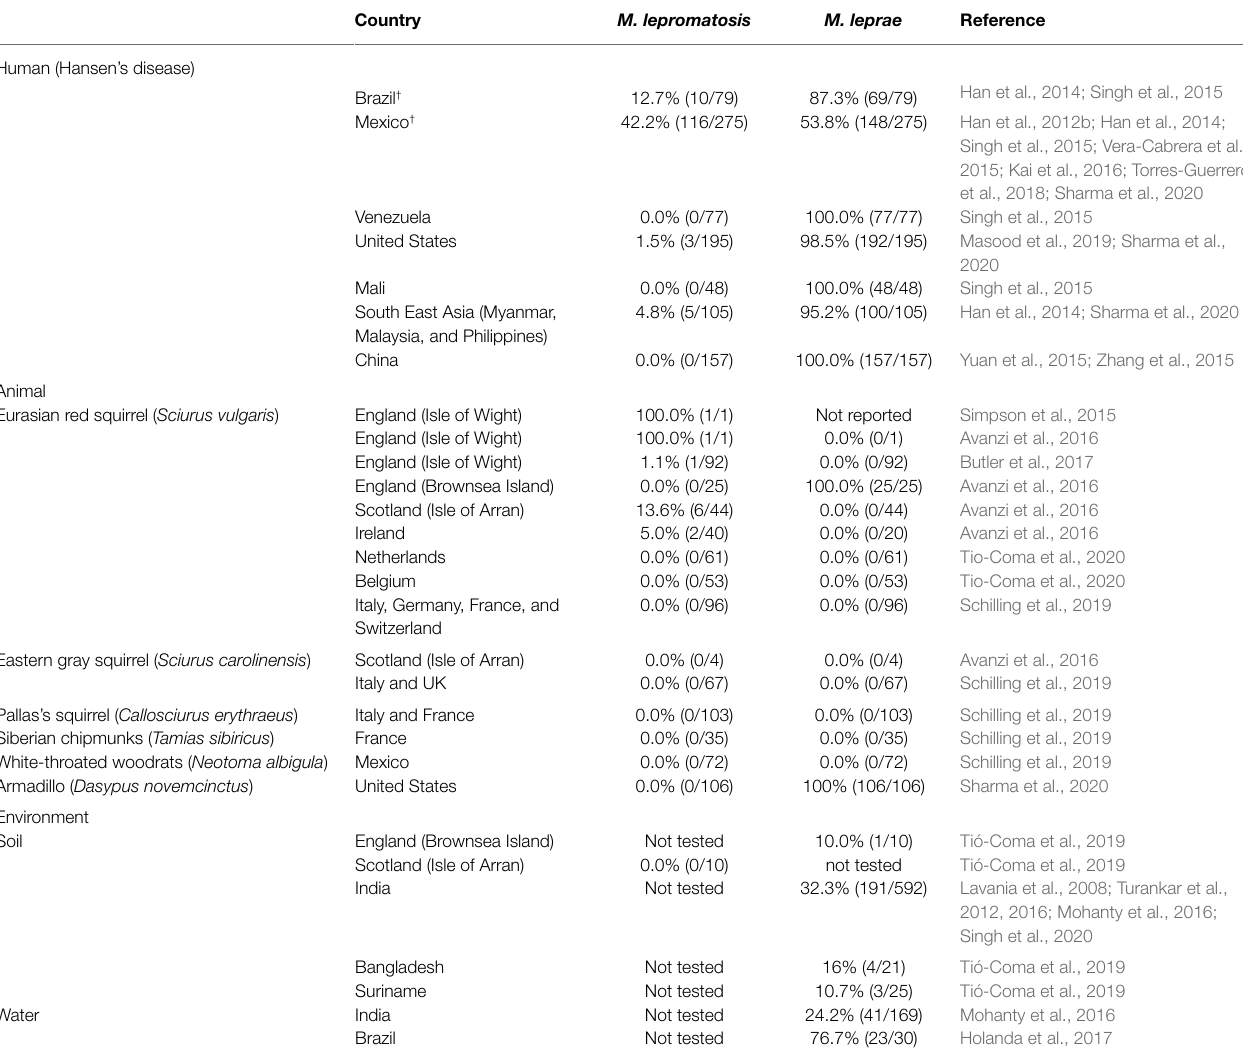
TABLE 1 | Survey findings of Mycobacterium leprae and Mycobacterium lepromatosis in Hansen’s disease and animal and environmental